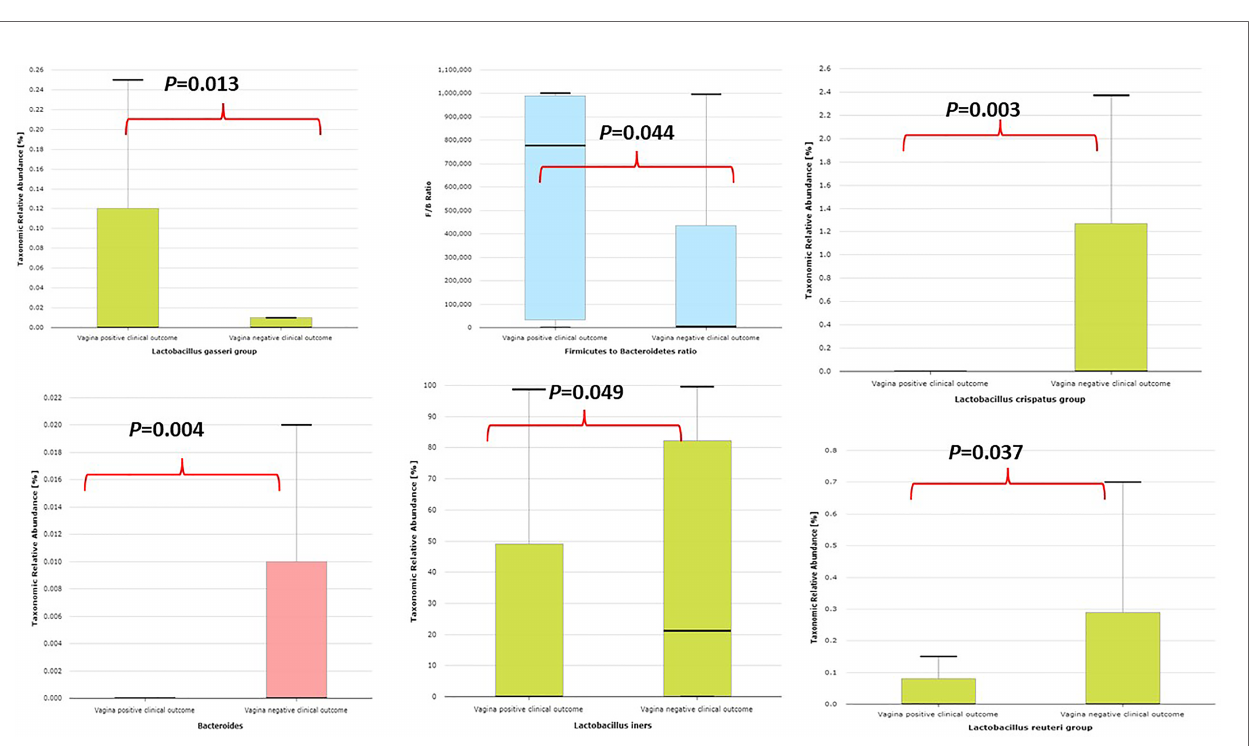
FIGURE 8 | Comparative relative abundance of some selected taxa showing signi fi cant difference between vaginal samples with positive IVF clinical outcome and vaginal samples with negative IVF clinical outcome.